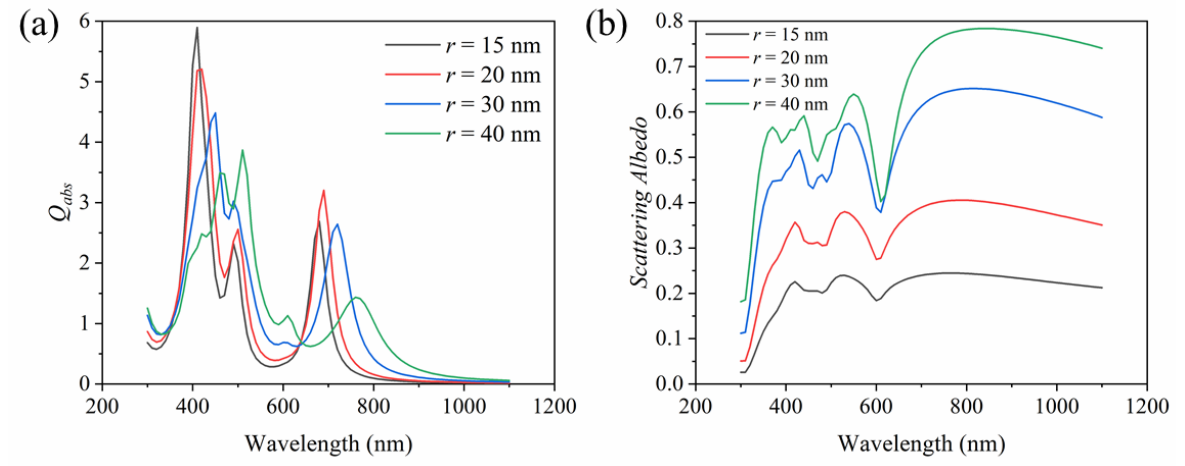
Figure 6. Effects of geometrical size on ( a ) absorption efficiency and ( b ) scattering albedo of dimer nanoparticle (average of three directions).